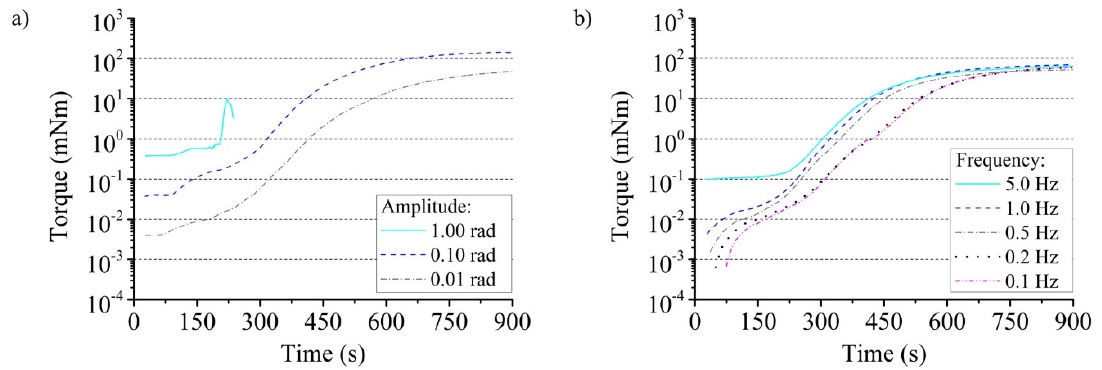
Figure 4. Influence of ( a ) amplitude and ( b ) frequency on torque measurement within reacting PUR foam in the rheometer test setup.